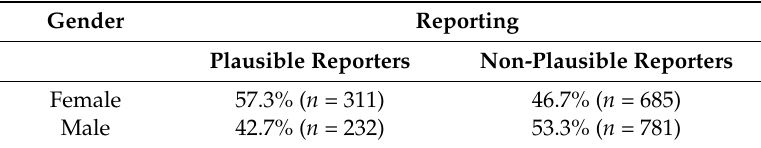
Table 2. Description of the ANIBES sample by gender and